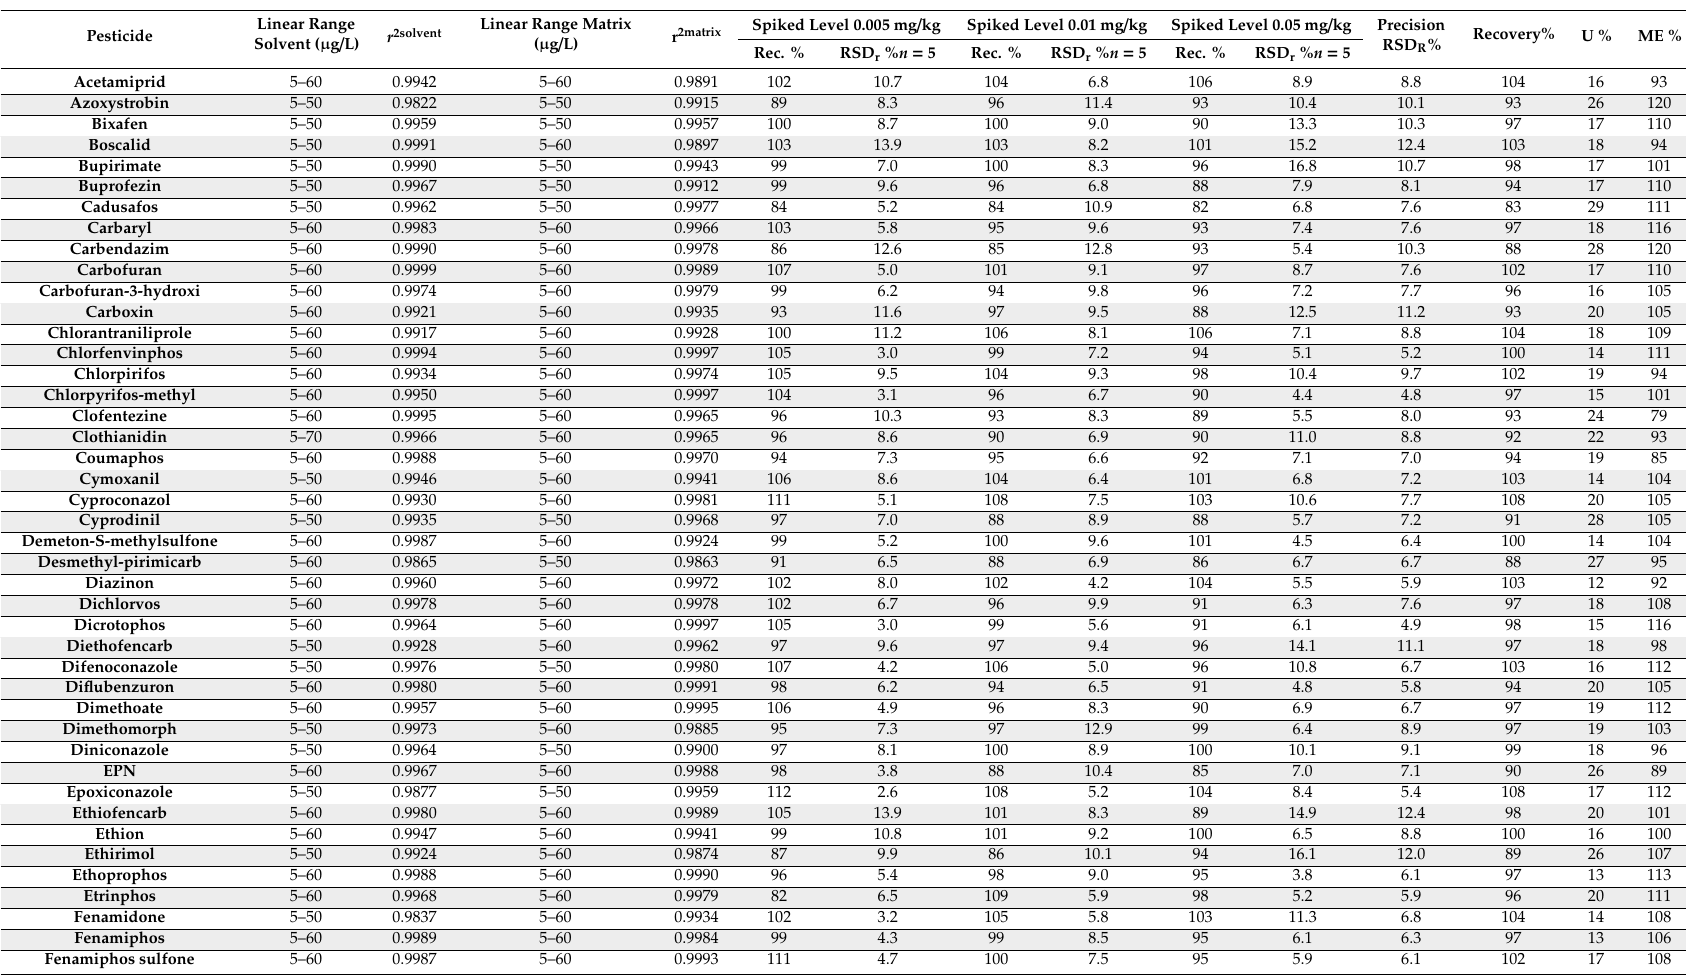
Table 3. Results of the validation of the HPLC-MS / MS method to determine 155 pesticides in rice: determination coe ffi cient ( r 2 ) in solvent and matrix-matched curves, recovery, and repeatability (RSD r ) and precision (RSD R ) at three di ff erent spiking levels, expanded uncertainty (U) and matrix e ff ect (ME). Linear Range Pesticide Solvent ( µ g / L) r